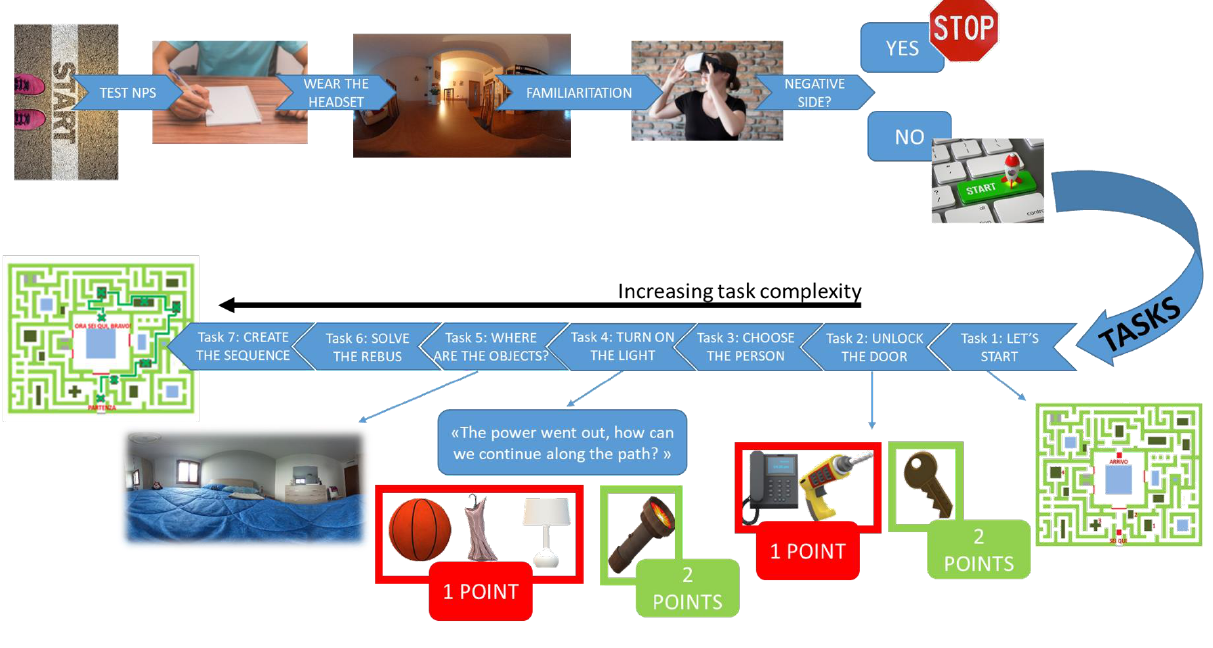
Figure 1. Evaluation process.